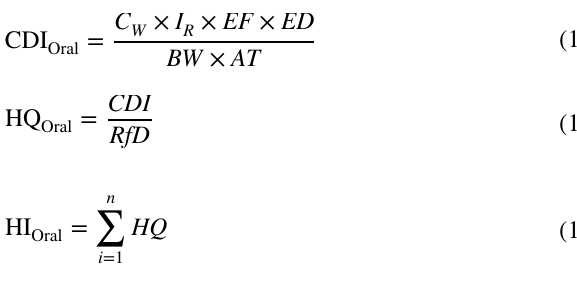
Table 2 Statistical summary of physiochemical and heavy metal parameters in groundwater of pre and post monsoon season